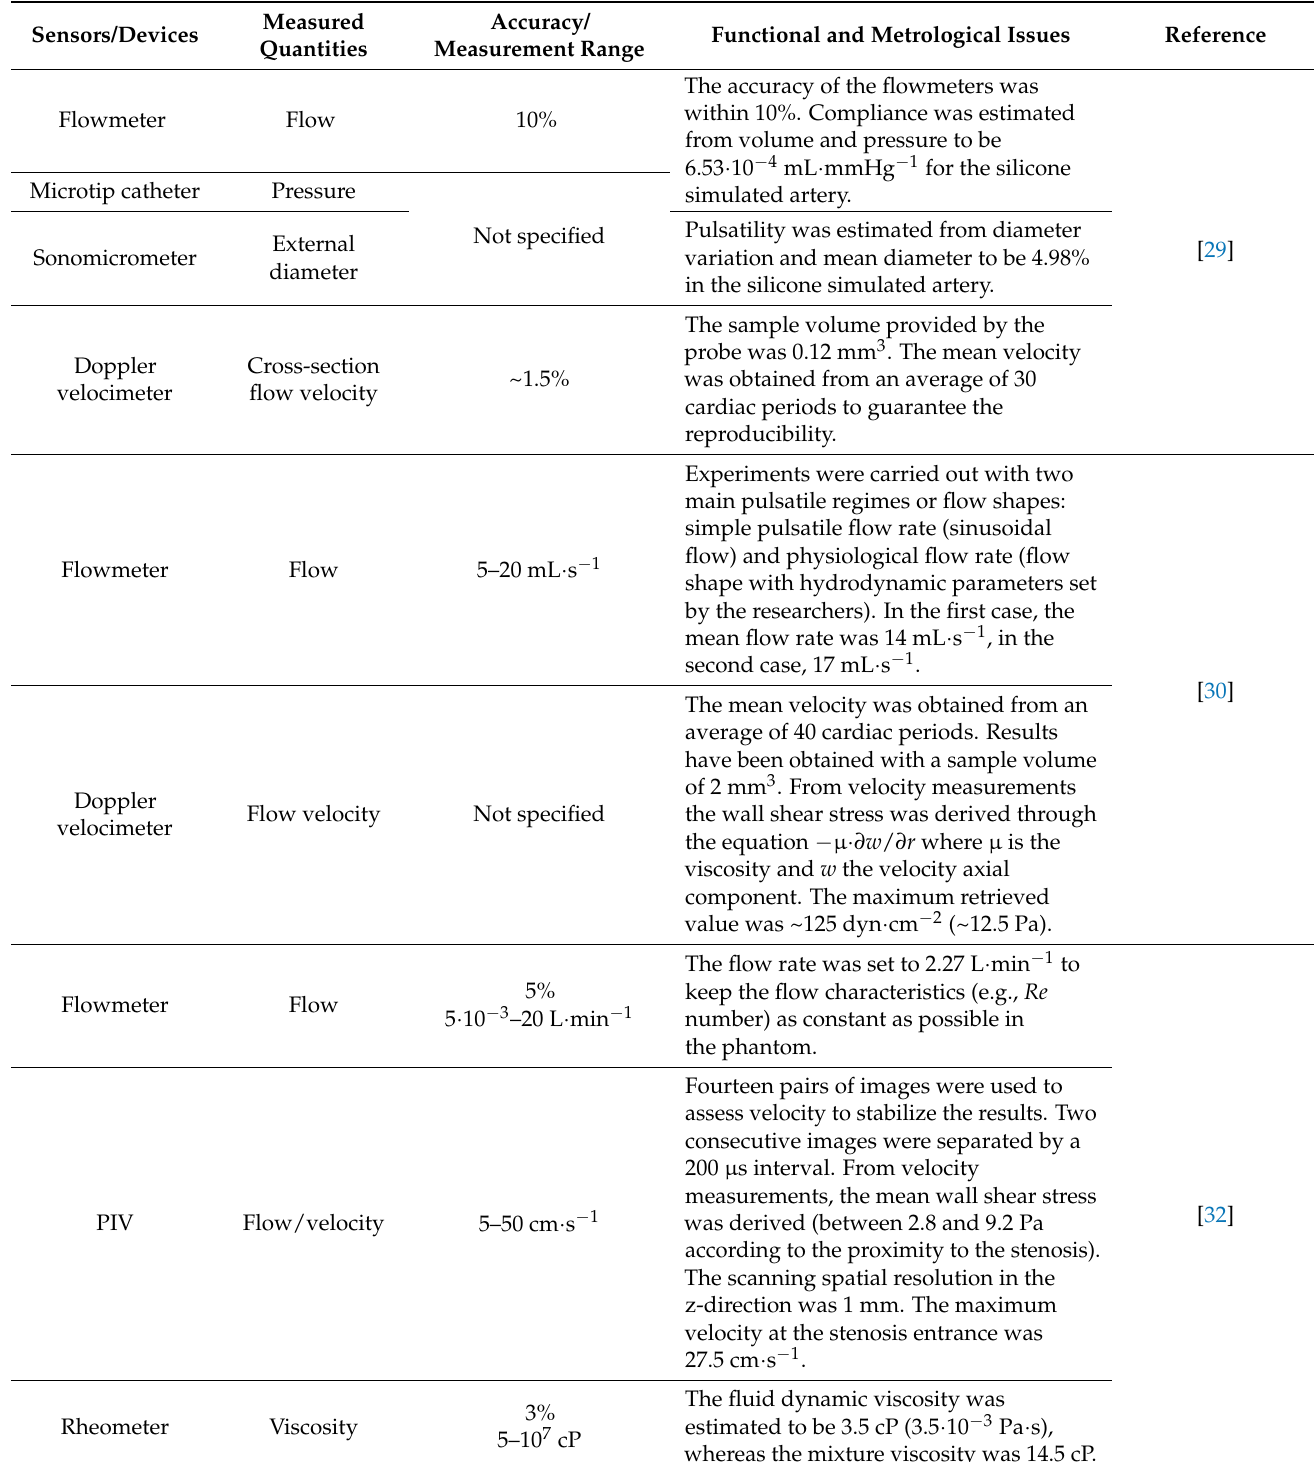
Table 3. Overview of stenosis and plaque